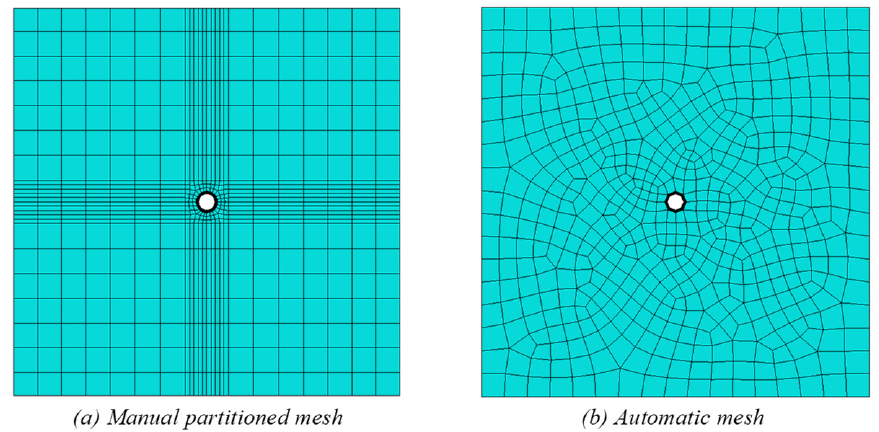
Figure 10. Cross section of concrete box mesh optimization.